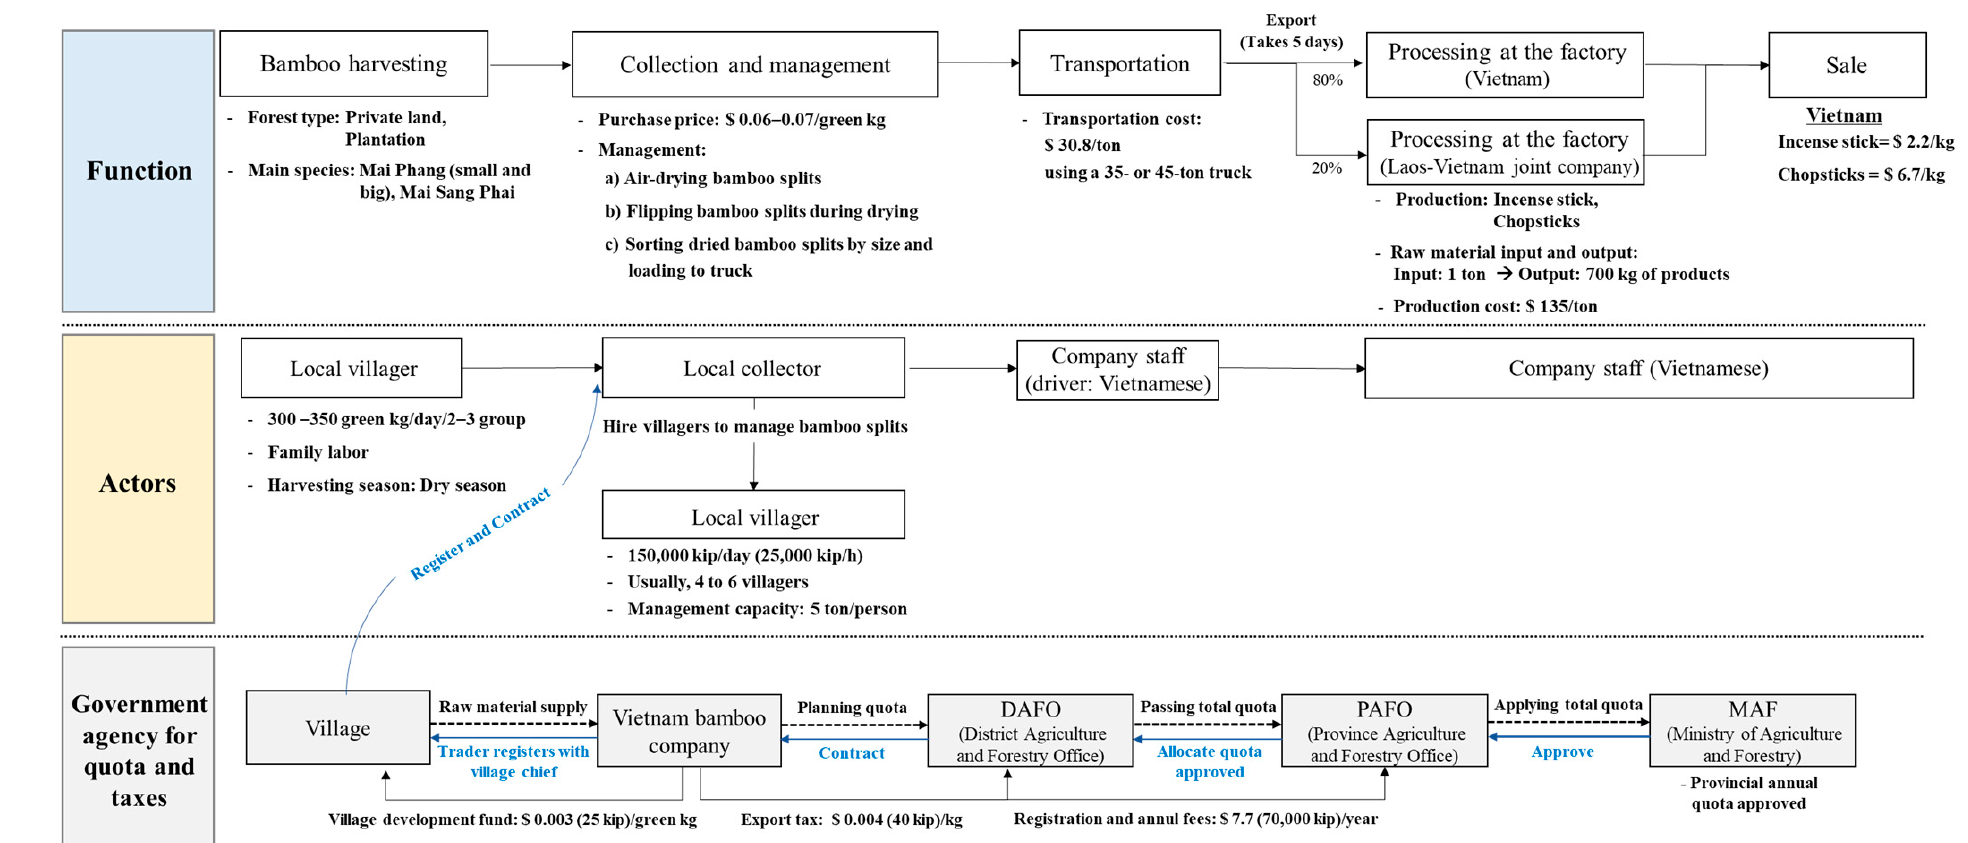
Figure 2. Overview of the existing bamboo products value chain in Nongboua village.